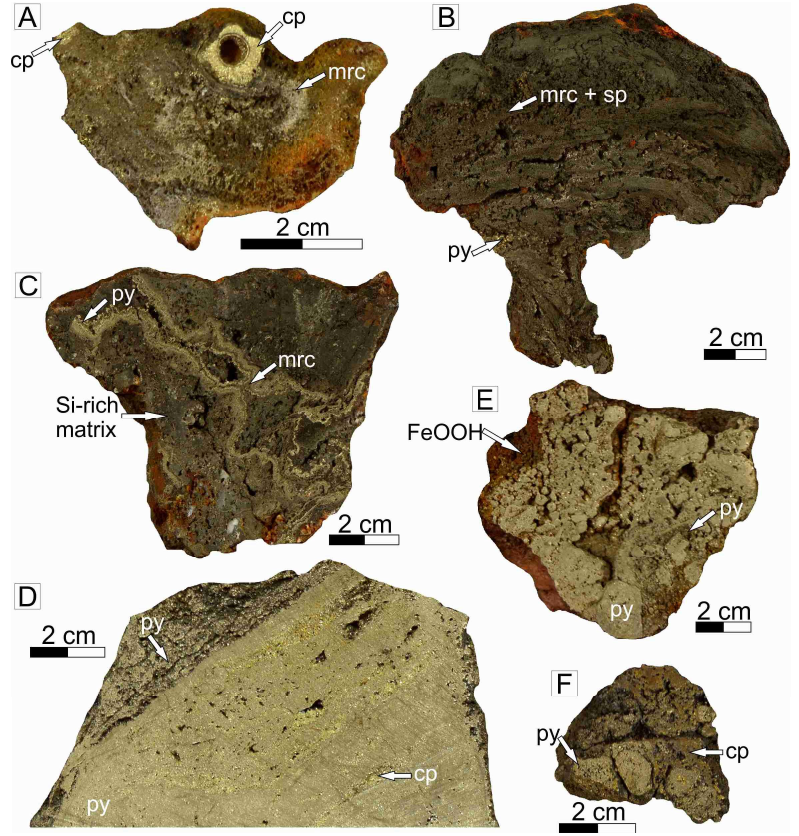
Figure 4. Representative sulfide samples obtained by HyBIS from extinct sulfide mound from the TAG area. ( A ) Chimney with a chalcopyrite-rich orifice surrounded by Cu-Fe-rich sulfides, New M. #2, 55-1. ( B ) Chimney wall fragment comprising marcasite that is intimately intergrown with sphalerite and pyrite, and is coated by amorphous silica (not visible on hand specimen scale), New M. #2, 55-3. ( C ) Chimney talus comprising banded marcasite and pyrite hosted in a silica-rich matrix, Shinkai M., 55-8. ( D ) Massive sulfide talus comprising pyrite with intercalated layers of chalcopyrite, Southern M., 21-3. ( E ) Sulfide breccia comprising angular clasts of pyrite hosted in a pyrite matrix, Southern M., 45-6. ( F ) Sulfide breccia comprising of sub-angular pyrite clasts that are hosted in a chalcopyrite rich matrix, Rona M., 45-7. Mineral abbreviations: cp: chalcopyrite, py: pyrite, mrc: marcasite, sp: sphalerite, Si: amorphous silica/quartz.